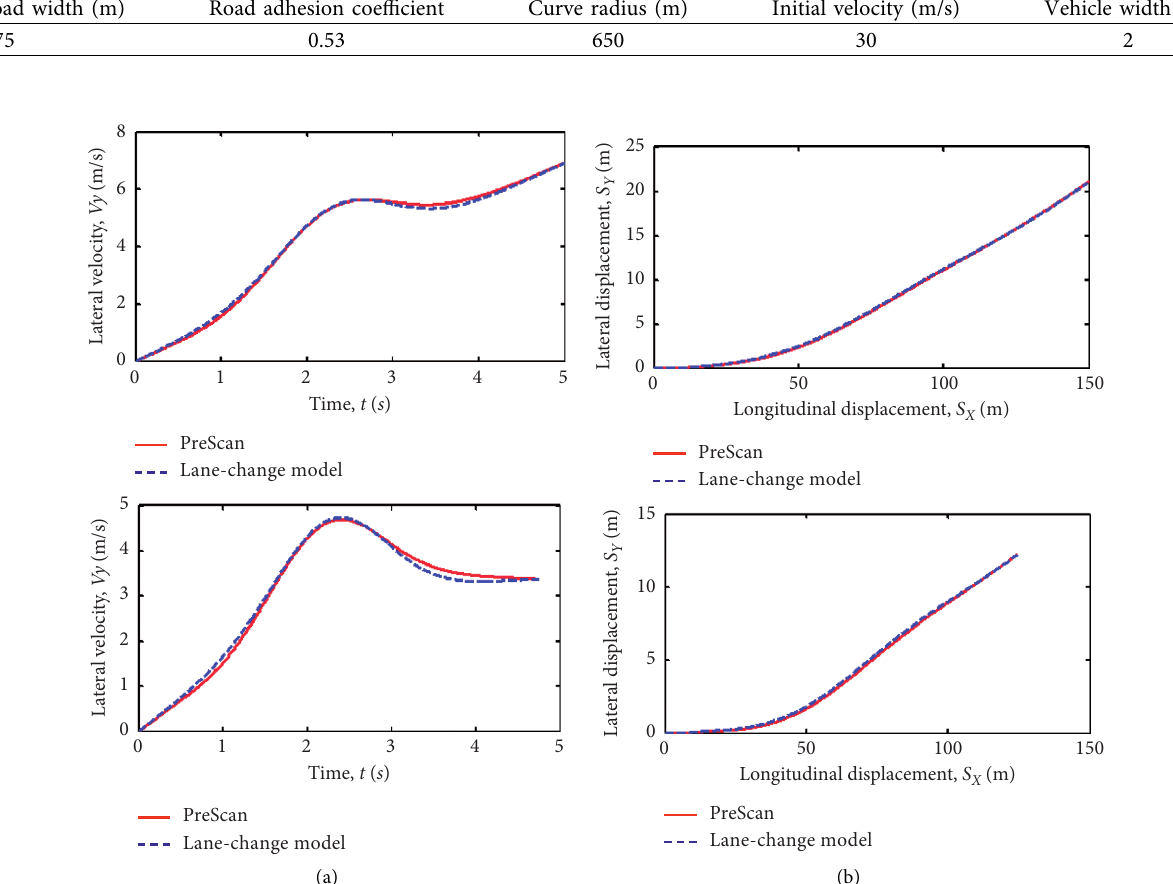
Figure 5: Comparative verifications with different simulation tools. (a) Lateral velocity at constant speed and 0.4Hz steering. (b) Global trajectory at constant speed and 0.4Hz steering.